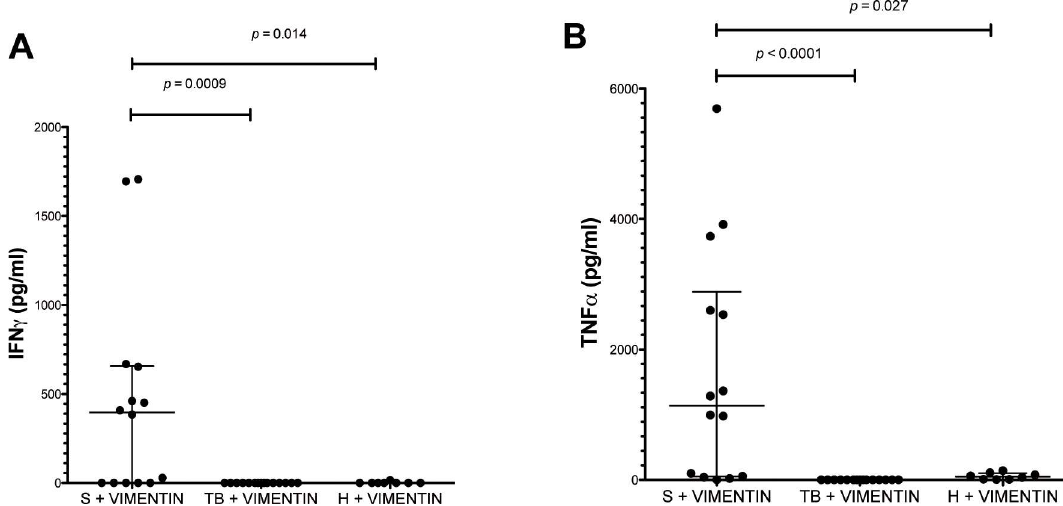
Fig 5. Total IFN- γ (Fig 5a) and TNF- α secretion(Fig 5b) after incubationof PBMCs from patients with sarcoidosis (S), tuberculosis(TB) or from healthy volunteers (H) with pooledrecombinant humanvimentin. Each dot represents the mean cytokine concentration of one PBMC sample stimulatedin duplicatewith protein for 36 hrs (after subtractionof the negative control well). Statistical significance betweencomparisons was determined by Mann-Whitney test. bronchoalveolar lavage (BAL) cells of sarcoidosis patients. Vimentin-peptides were amongst